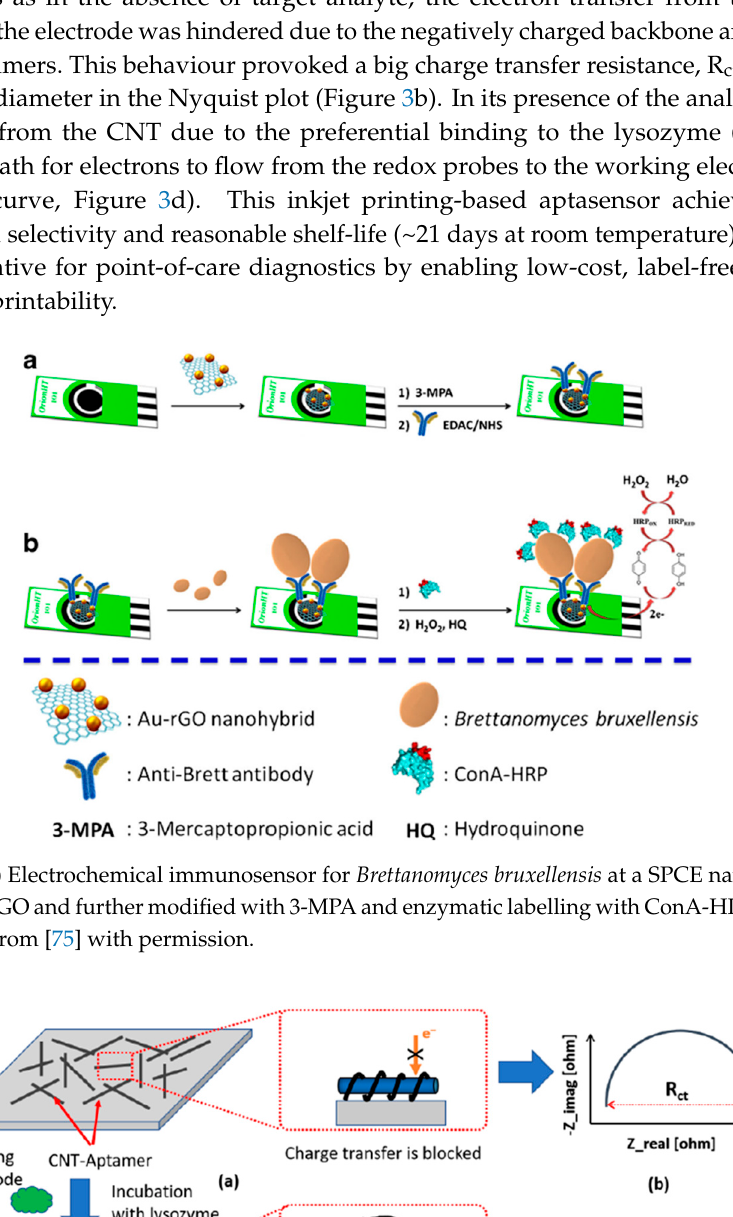
Figure 3. Inkjet printing-based aptasensor for the impedimetric detection of lysozyme. Configurations ( a , c ) and corresponding Nyquist plots ( b , d ) obtained using as redox probe [Fe(CN) 6 ] 4 − / 3 − in the absence ( a , b ) and in the presence ( c , d ) of target lysozyme. Reprinted and adapted from [66] with permission.